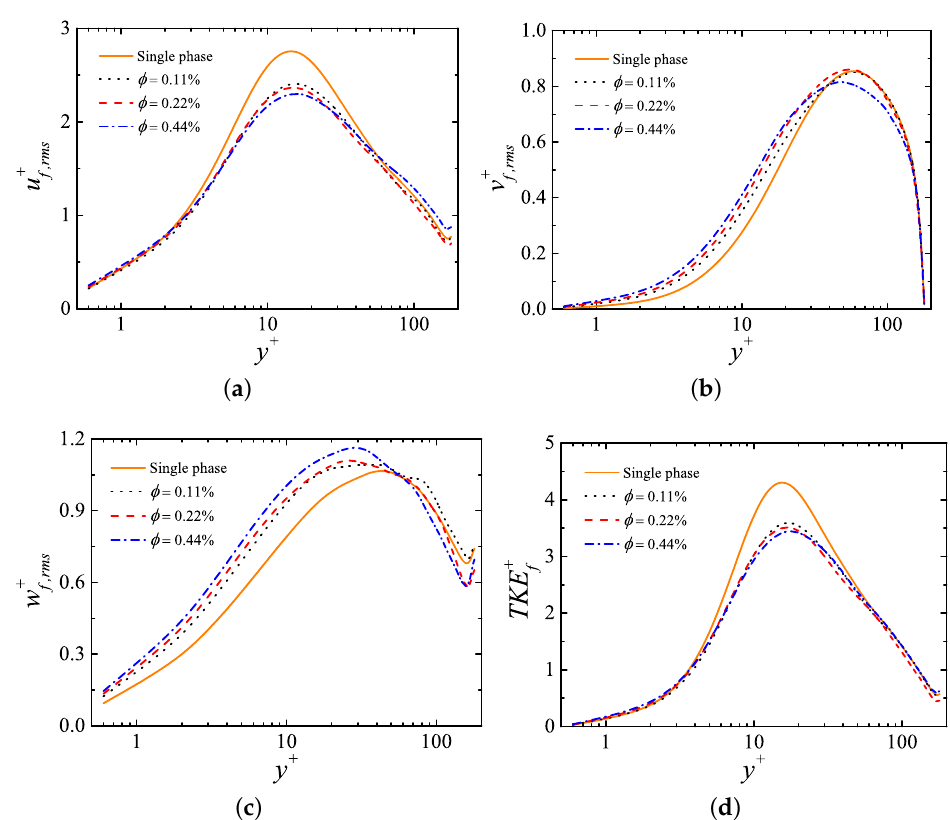
Figure 4. ( a – c ) Fluid RMS velocity fluctuations in the streamwise, wall-normal, and spanwise directions, respectively, and ( d ) fluid turbulent kinetic energy (TKE).